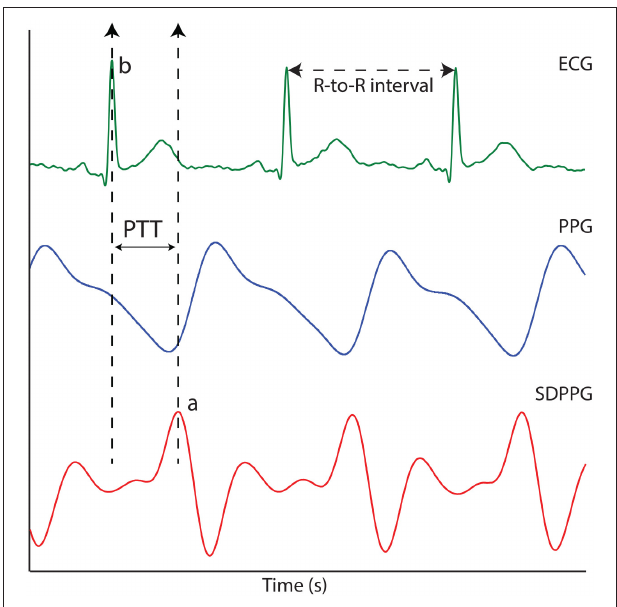
FIGURE 1 | The ECG signal, the PPG signal and the second derivative photoplethysmographic (SDPPG). PTT is the time difference between points “a” and